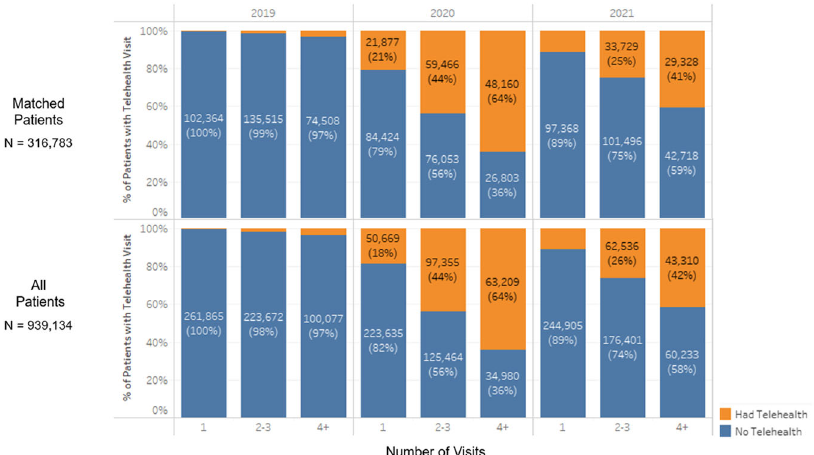
Fig. 2 Telehealth use occurs more in patients with multiple primary care visits. Number and percent of patients with no (blue) or at least one telehealth visit (orange) grouped by number of primary care appointments in that year for matched patients (top) and all patients